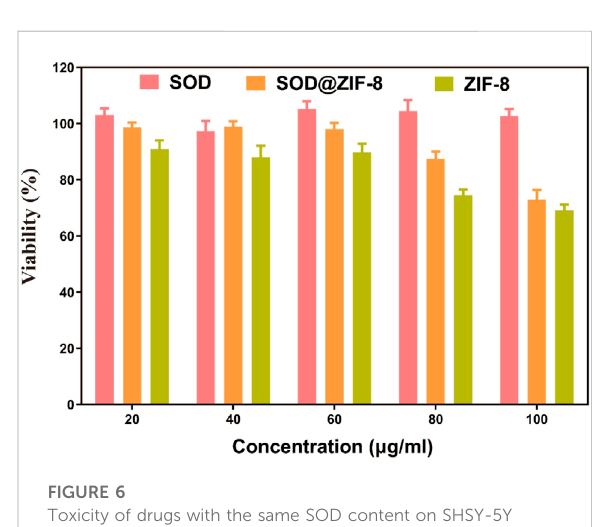
FIGURE 6 Toxicity of drugs with the same SOD content on SHSY-5Y cells. The concentrations of SOD@ZIF-8 varied from 20 to 100 μ